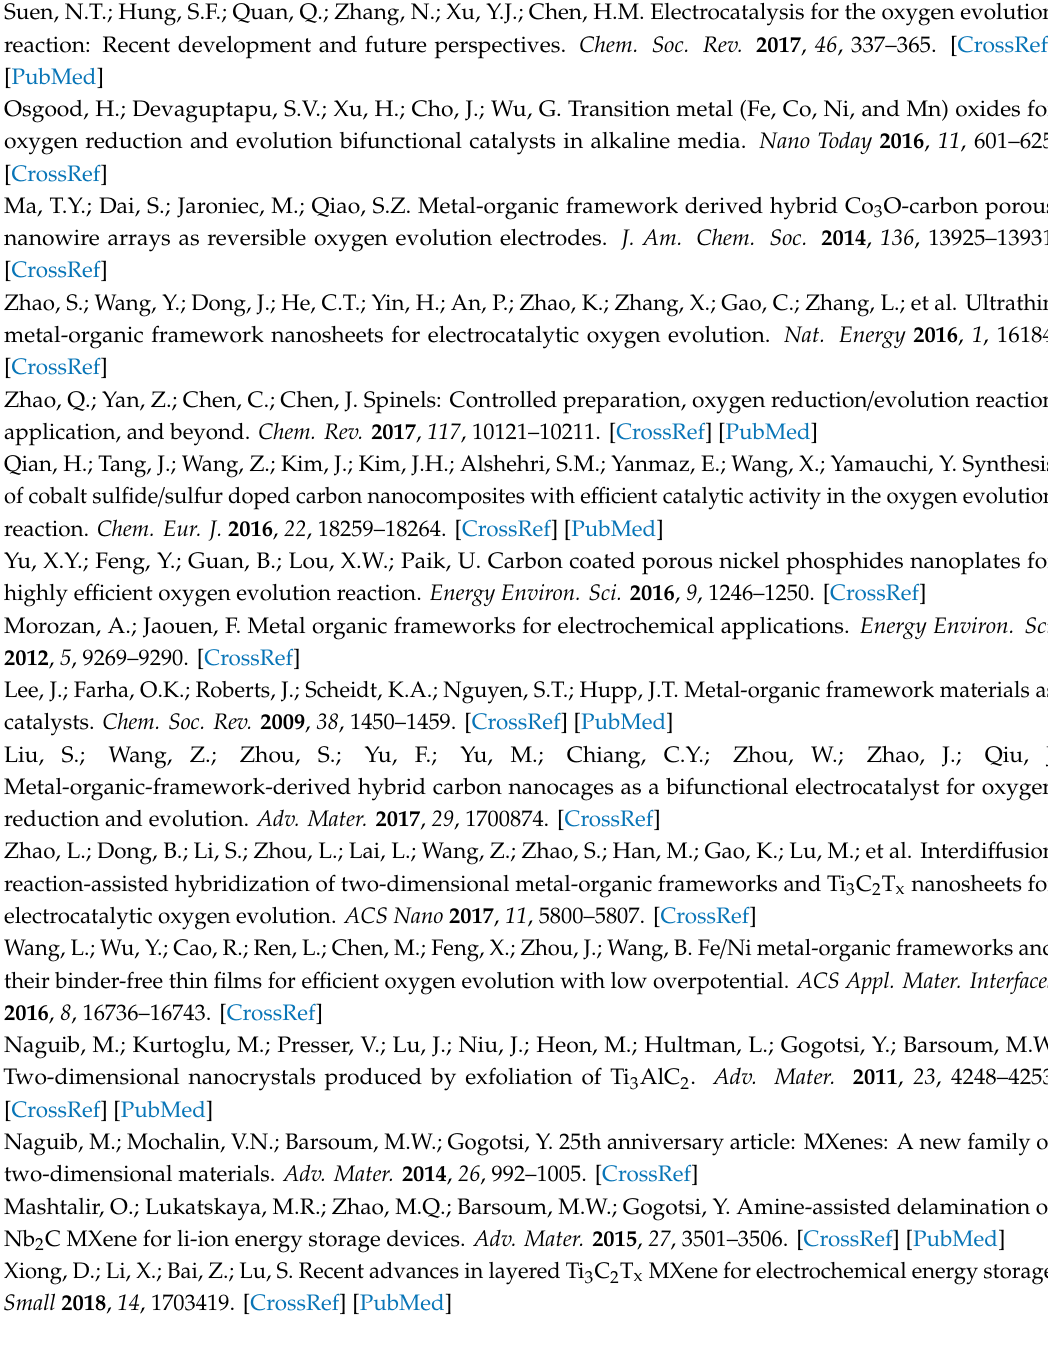
XPS results of Ti 3 C 2 T x and CoNi-ZIF-67, Figure S7: CV curves in a potential range of 1.023–1.073 V vs. RHE of